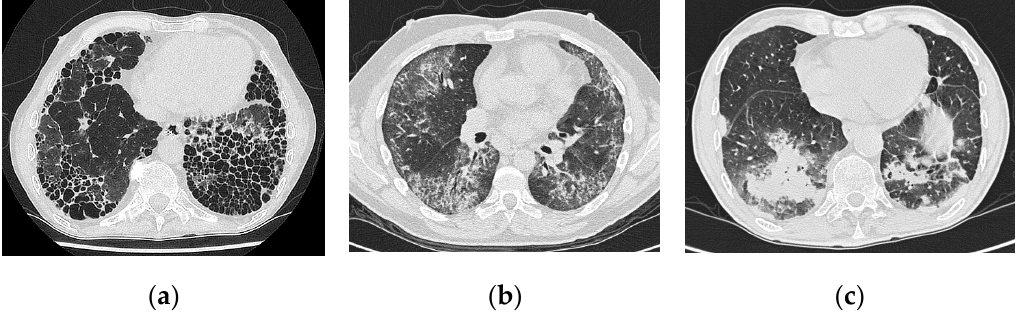
Figure 1. HRCT images showing ( a ) rheumatoid arthritis-associated usual interstitial pneumonia (RA-UIP), ( b ) rheumatoid arthritis-associated non-specific interstitial pneumonia (RA-NSIP), and ( c ) rheumatoid arthritis-associated organizing pneumonia (RA-OP).